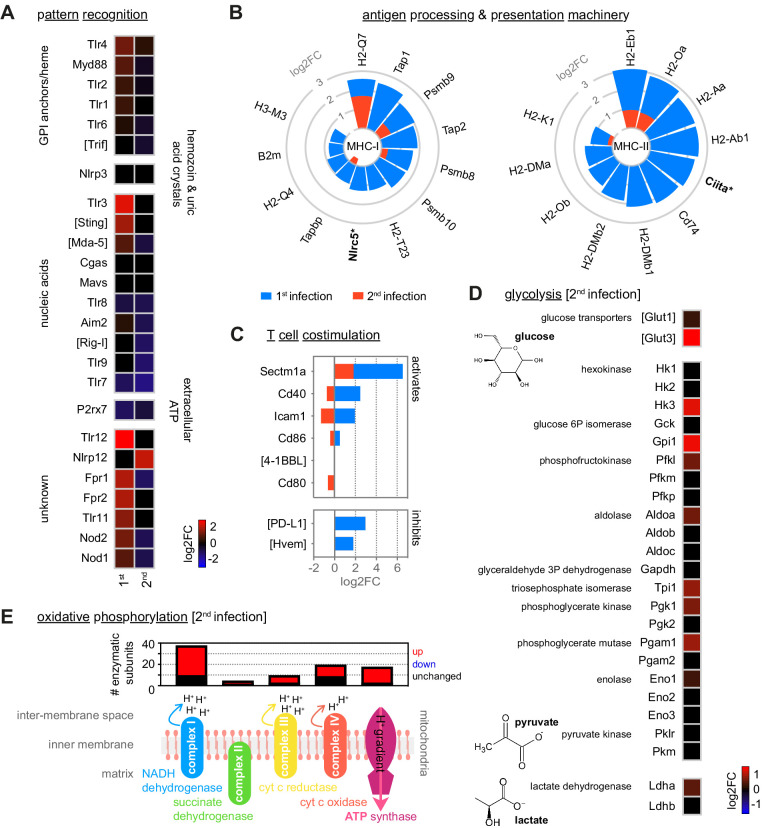
Monocytes minimise inflammation in tolerised hosts.(A–C) RNA sequencing of spleen monocytes flow-sorted from mice experiencing their first or second infection (acute, 7 days p.i.). Shown is the log2 fold change (FC) of (A) pattern recognition receptors (PRR); (B) class I and class II antigen processing and presentation pathways (inc MHC transactivators*); and (C) T cell co-stimulation and inhibitory ligands. Data are shown relative to uninfected controls. If parasite- or host-derived ligands have been identified for PRR in malaria these ligands are labelled. (D) Log2FC of the major glucose transporters and glycolytic enzymes in spleen monocytes during the acute phase of second infection (7 days p.i.) – data are shown relative to uninfected controls. Note that under anaerobic conditions pyruvate can be further converted to lactate by lactate dehydrogenase, which is also shown. (E) Transcriptional regulation of oxidative phosphorylation in spleen monocytes during the acute phase of second infection (7 days p.i.). Data show the number of enzymatic subunits that are transcriptionally up- or downregulated compared to uninfected controls (padj <0.01, >1.5-fold change) – all subunits that are required to form complex I to IV in the electron transport chain and ATP synthase are shown. In (A–E), n = 5 for infected mice and n = 6–7 for uninfected controls. Square brackets indicate that common gene names were used.